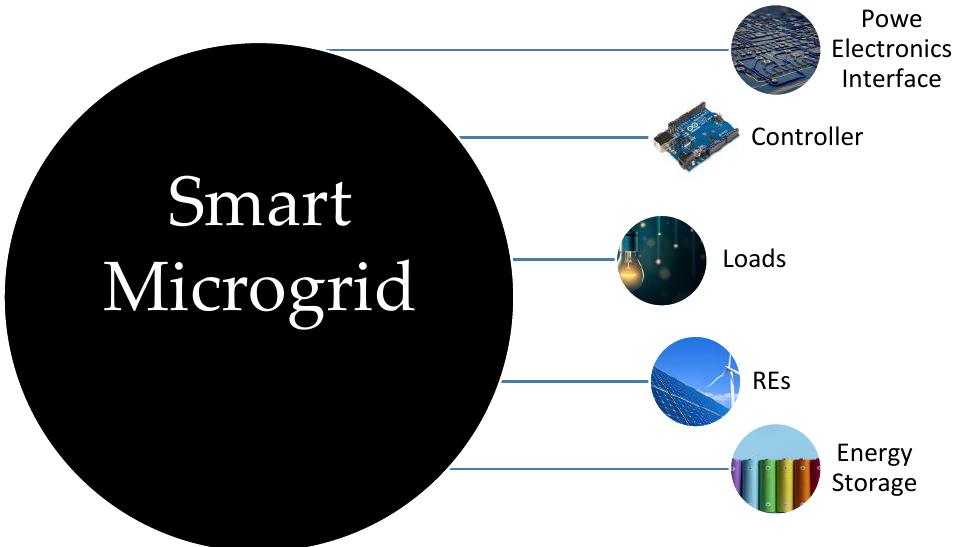
Figure 1. The basic structure of a smart microgrid.